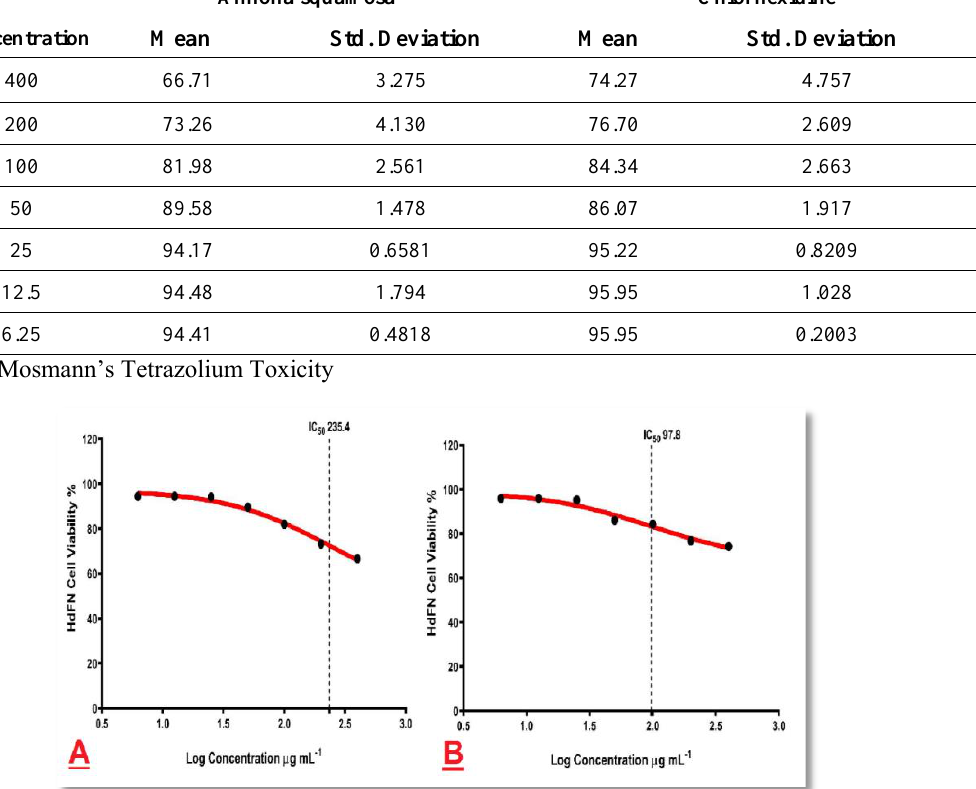
Figure 1 : Half-maximal inhibitory concentration of cells on Human dermal fibroblast of neonate cell line of (A) Annona squamosa pulp extract (B) the positive control chlorhexidine gloconate 0.12%